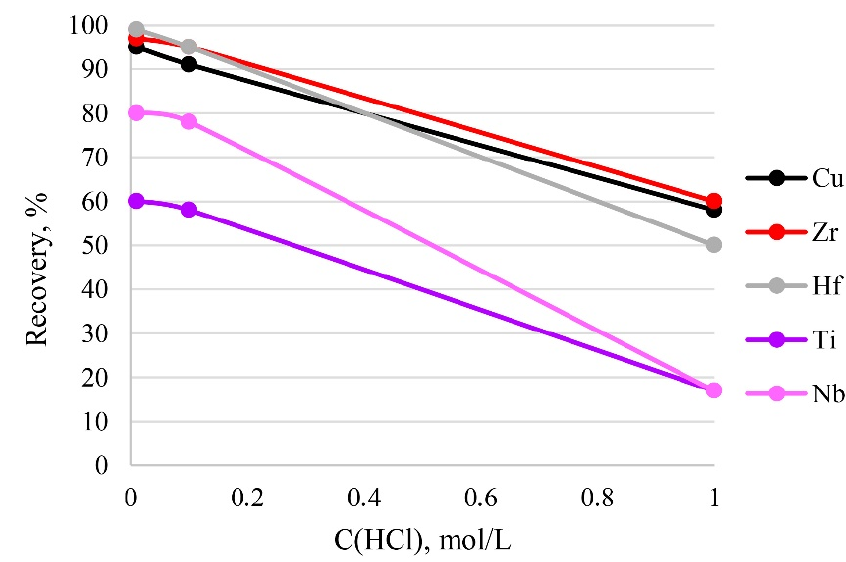
Figure 8. The dependence of recovery on acidity. Sorption conditions: C EDTA/NH3 = 50/2500 mg/L, m PTE = 0.1 g, V liquid phase = 10 mL, t = 1 h, T = 60 °C, C analytes = 1 mg/L.